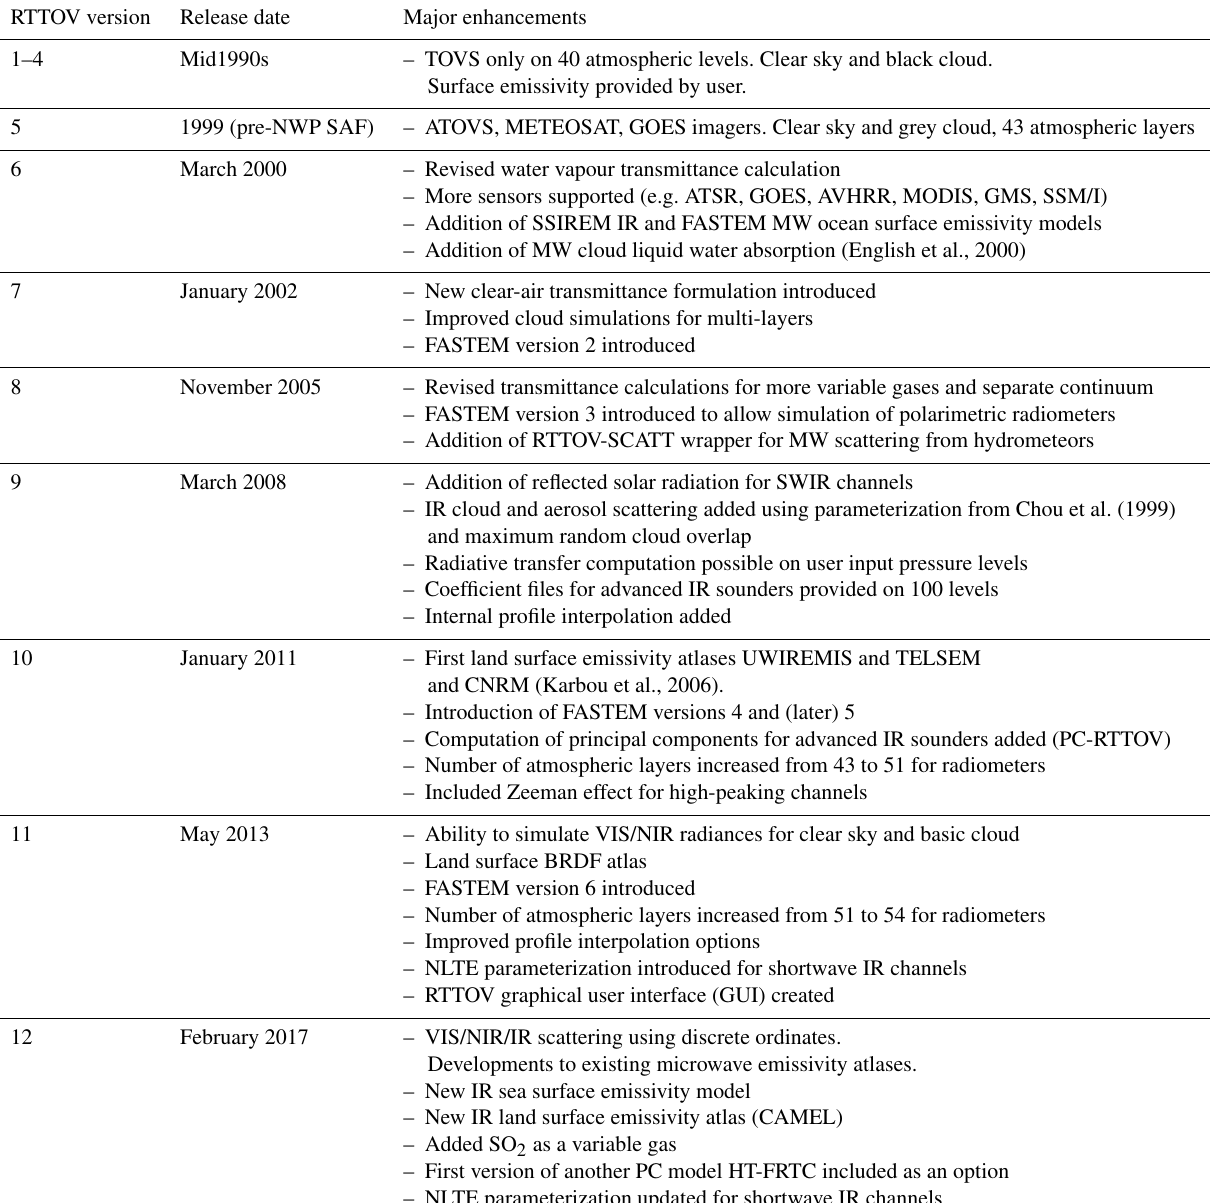
Table 1. Major enhancements to RTTOV since the initial versions developed at ECMWF in mid